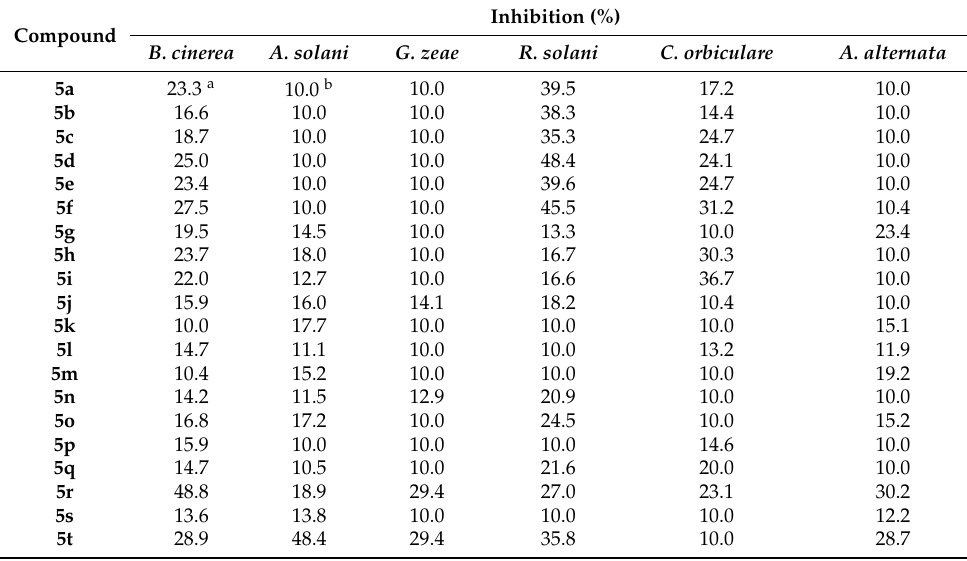
Table 3. Antifungal activity of synthesized compounds at 50 µg/mL. Compound